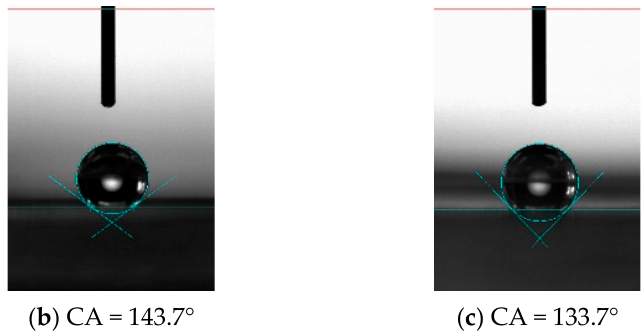
Figure 15. Non-microstructured PDMS planar hydrophobic properties. ( a ) Surface before processing; ( b ) surface after processing.